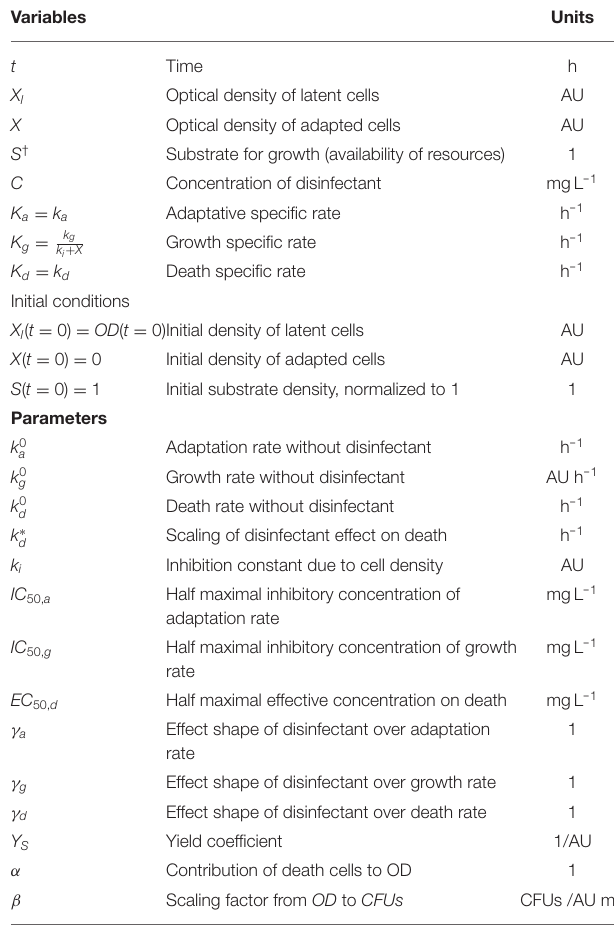
TABLE 2 | Variables, initial conditions, and parameters used for the mechanistic model.